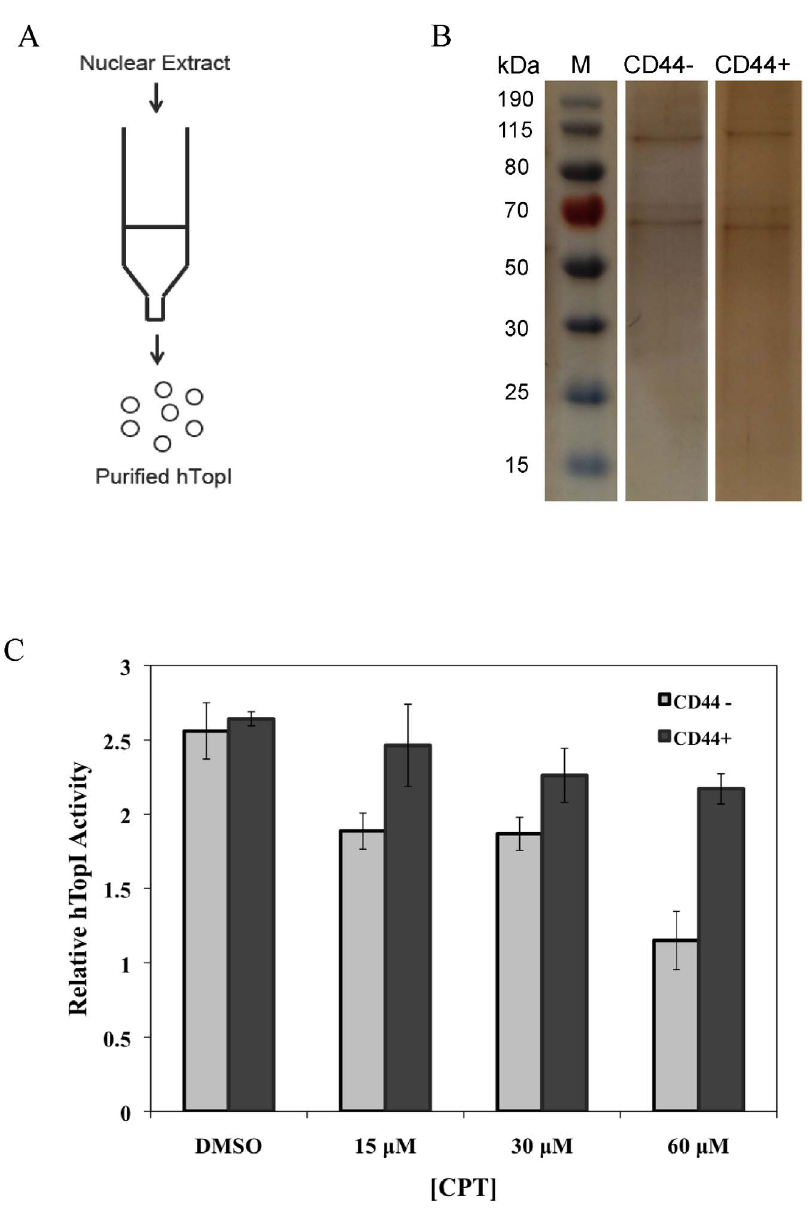
Figure 2. CPT sensitivity of TopI purified from nuclear extract of FACS sorted CD44 + or CD44 2 cell subpopulations. ( A ) Graphical illustration of column purification. ( B ) Shows the results of SDS phage followed by silver stain visualization of the purified enzyme fractions. Lane 1, is a size marker, lanes 2 and 3 show the enzyme fractions purified from CD44 2 and CD44 + cells, respectively. ( C ) Shows the CPT sensitivity of the purified enzyme as measured by REEAD. S(hTopI) was incubated with TopI purified from the CD44 + or CD44 2 cells in the presence of DMSO or 15 m M, 30 m M or 60 m M CPT as indicated. The results of three independent experiments were quantified and depicted as a bar chart as described in the legend of figure